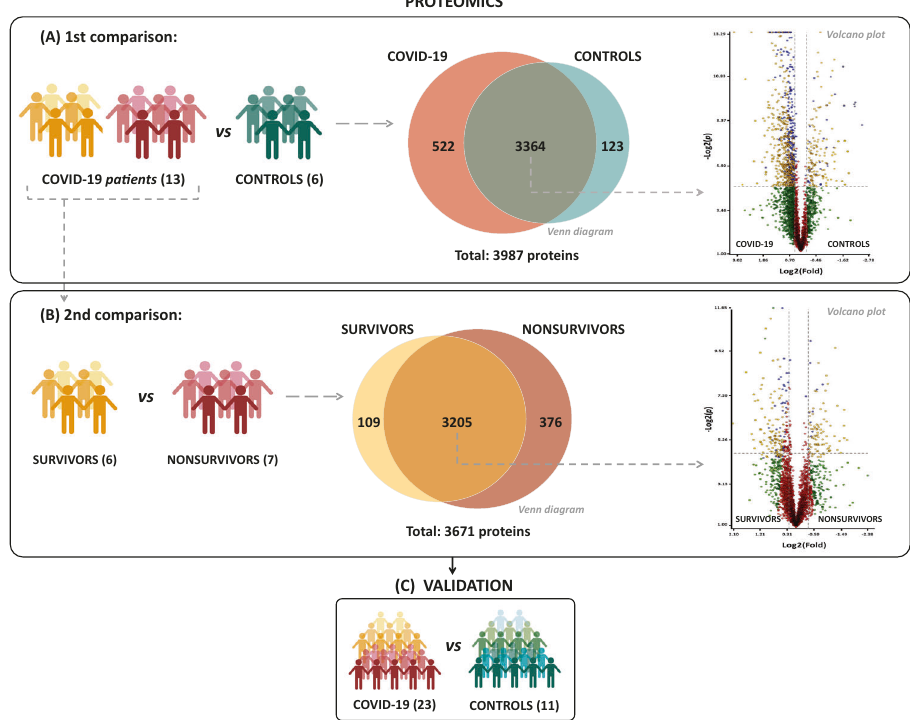
Fig. 1 Experimental design and proteomic results. A Schematic representation of the experimental setup for platelet proteome screening in COVID-19 patients (COVID-19, survivor, and nonsurvivor groups) compared with healthy volunteers (controls). B Venn diagram representing total, unique, and shared protein identi fi cations among the experimental groups. C Volcano plot of all shared proteins in the comparisons between COVID-19 patients and controls and among survivors and nonsurvivors. Each dot represents a protein mapped according to its log2 (fold change) on the y -axis and its − log2 ( t test p value) on the x -axis. The red dots indicate proteins that did not satisfy the fold-change cutoff and p value (0.05). Green dots depict protein entries that met the fold-change cutoff but not the p value. Orange dots indicate proteins that satis fi ed both fold-change and p value but had low abundance, as determined by an additional stringency fi lter. Blue dots represent protein entries that met all statistical fi lters and were selected for further Venn diagram of Fig. 1A. Exclusively detected proteins (EPs) were identi fi ed in at least two biological samples with technical triplicates in each group. Among the COVID-19 group, a set of 3671 proteins were identi fi ed, of which 109 proteins were found to be EPs to SURVIVORS and 376 to the NONSURVIVORS groups, represented in the Venn diagram of Fig. 1B. A list containing all found in Supplemental Table 1. Proteins that were shared in both groups (intersection of Venn diagram) were submitted to label- free quantitation and statistical analysis with stringent criteria ( p value < 0.05) to highlight the differentially expressed proteins (DEPs). A set of 814 proteins were found to be DEPs between COVID-19 and CONTROLS and 245 DEPs among SURVIVORS and NONSURVIVORS, represented in the volcano plots of Fig. 1A, B, respectively. The differentially abundant proteins that represented the most relevant biological processes were submitted to validation experiments in a cohort with a larger number of samples (Fig. 1C). All datasets, including fold-change and p values for both comparisons, are provided in Supplemental Table 2. Based on the results from both comparisons and focusing on EPs and DEPs, interactome analyses of enriched terms were generated to highlight the most relevant biological processes (log P < − 3.0) (Fig. 2). The results indicate a cellular activation